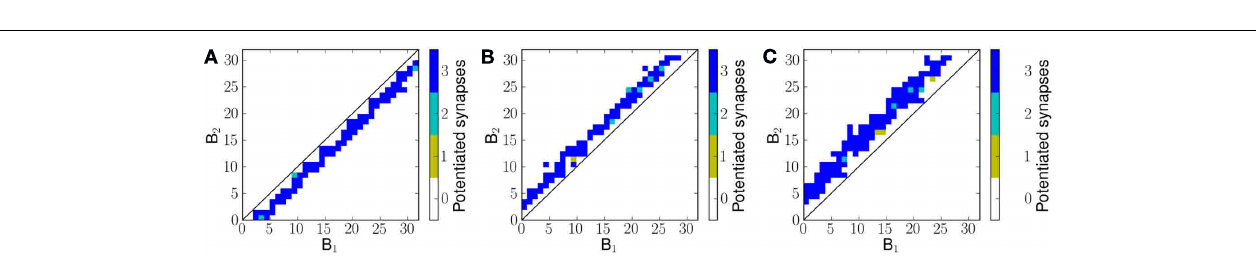
FIGURE 7 | Potentiated synapses, or the effective final connectivity from B 1 neurons to B 2 neurons, after exposing the network to linear frequency sweeps at velocities (A) − 0.8ms − 1 (B) 0.8ms − 1 and (C) 1.2ms − 1